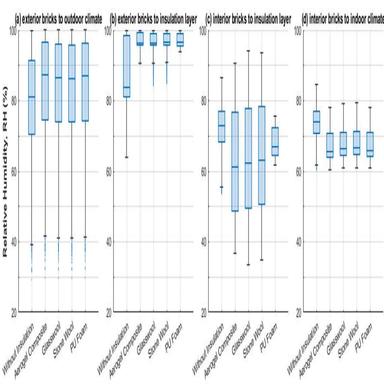
Relative humidity of the (a) exterior bricks interface to outdoor climate, (b) exterior bricks interface to insulation layer, (c) interior bricks interface to insulation layer, (d) interior bricks interface to indoor climate.